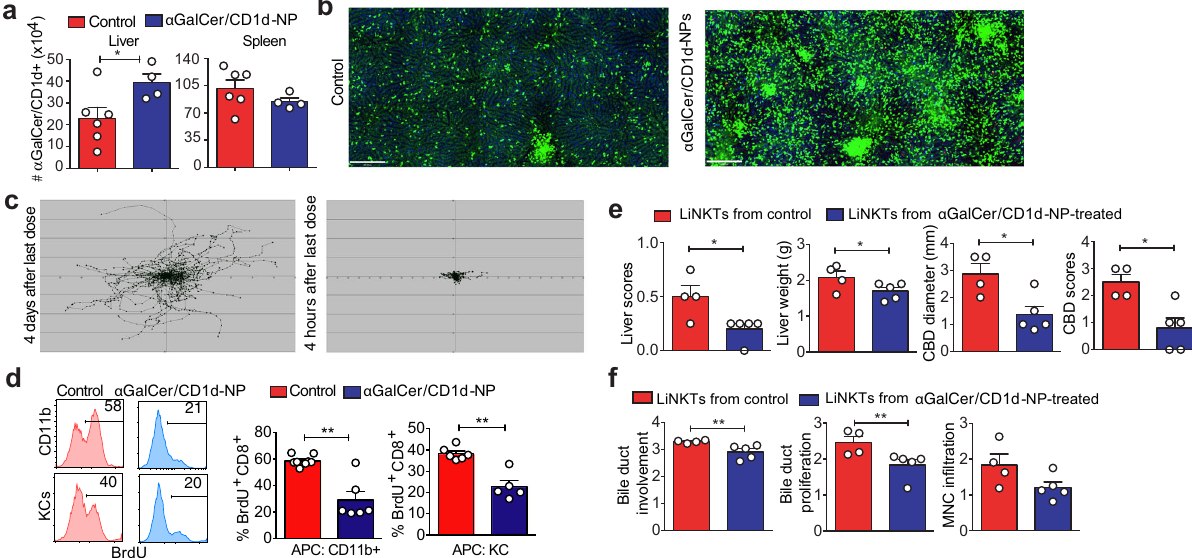
Fig. 2 α GalCer/CD1d-NPs activate, expand and elicit immunoregulatory properties on liver iNKT cells. a Absolute numbers of α GalCer/CD1d tetramer + iNKT cells in the liver and spleen of control NOD. c3c4 mice ( n = 6, untreated) vs. NOD. c3c4 mice treated with α GalCer/CD1d-NPs ( n = 4). Cells were enumerated 2 – 3 days after the last α GalCer/CD1d-NP dose. b Images depicting increased accumulation of Cxcr6 GFP/ + cells in the liver in response to α GalCer/CD1d-NP vs. Cys-NP treatment of B6. Ifng-Delta-ARE + /- . Cxcr6 GFP/ + mice. c Migration paths of Cxcr6 GFP/ + cells in the livers of these mice within 4 days of the 10th dose and 4 h of an α GalCer/CD1d-NP dose. d Representative FACS histograms and average percentages of BrdU incorporation by splenic 8.3-CD8 + T cells in response to NRP-V7 peptide-pulsed PCLN CD11b + or liver KCs puri fi ed from Cys-NP- or α GalCer/CD1d-NP-treated mice. Data correspond to n = 8 and 6 (2 experiments) in the left panel and n = 6 and 5 (2 experiments) in the right panel. e , f Evaluation of gross ( e ) and microscopic ( f ) PBC scores in NOD. c3c4.scid hosts transfused with iNKT cells isolated from the livers of Cys-NP- or α GalCer/CD1d-NP-treated mice followed, 1 day later, by transfusion of whole splenocytes and PCLN cells from diseased NOD. c3c4 donors. Data correspond to n = 4/group (red) and 5/group (blue) from left to right. Data are represented as means ± SEM and were compared using one tail Mann – Whitney U test ( a , d – f ). * P < 0.05; ** P < 0.01; *** P < 0.001; **** P <